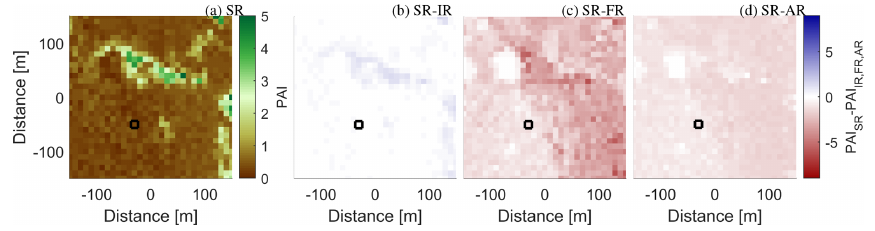
Figure 4. PAI estimates from the Falster winter scan using various methods. (a) The PAI in a 10m × 10m square grid based on the SR method. Panels (b) , (c) , and (d) show the difference between SR and the IR, FR, and AR reference methods, respectively. The black square marks the edges for the data used in Sect.